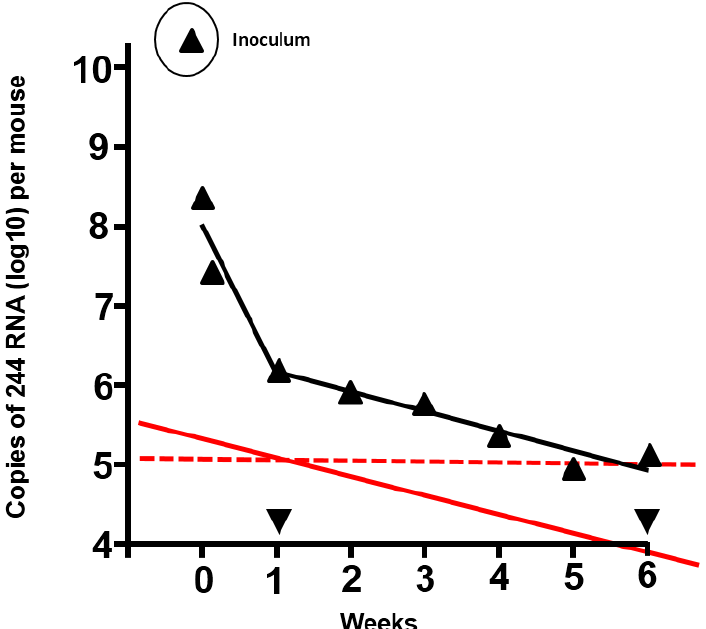
Figure 1. Duration of residence of 244 RNA in the lungs of mice inoculated with 12 µg 244 DI virus protein, and prediction of the duration of protection from infectious challenge virus. The amount of DI RNA was determined by quantitative PCR (▲) (adapted from [2]). ▼, PCR signal from lungs of mice that were inoculated with diluent. Mice treated with 1.2 µg 244 DI virus were protected from lethal challenge with infectious IAV after 7 days had elapsed. However, 244 DI virus did not protect at 14 days after treatment, indicating that the DI RNA had declined to a sub-protective level and that no anti-DI virus immunity had been generated. The solid red line shows the amount and decline of the DI RNA in the lower DI virus dose, assuming that the amount of DI RNA in the lung and the kinetics of decline were proportional to the higher dose (in black). The red dashed line is an extrapolation from the 1.2 µg dose that was still protective after 7 days and suggests that the 12 µg dose of 244 DI virus would still be protective at 5 to 6 weeks after treatment. It is calculated that DI RNA from the high dose declines to zero in approximately 6 months.